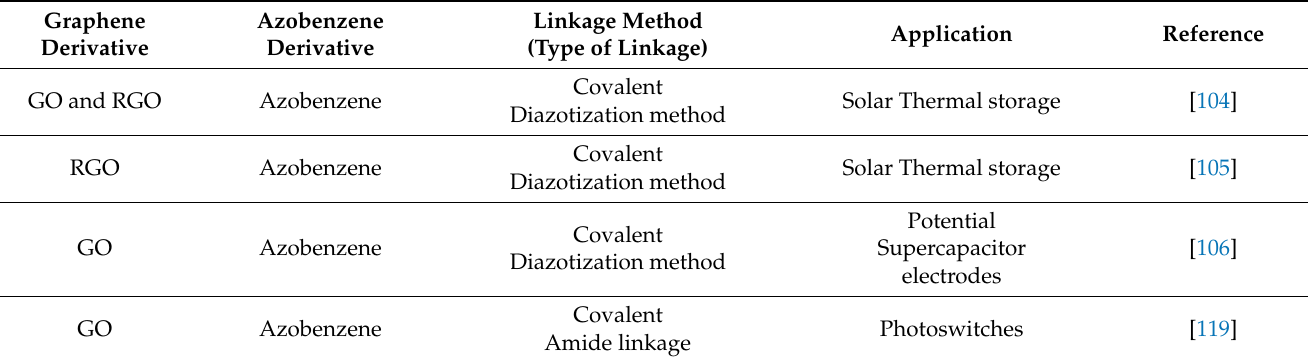
Table 3. Applications of GD-AZO